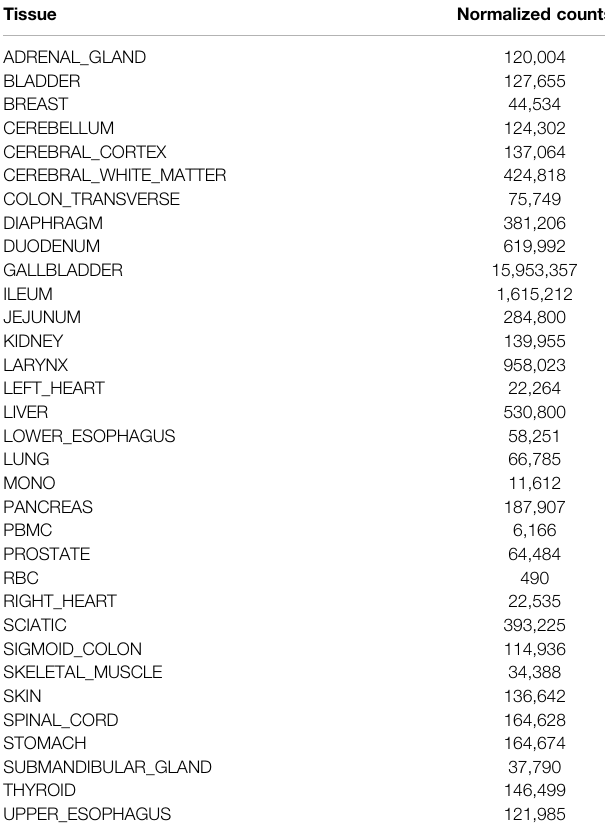
TABLE 2 | Tissue-enriched gallbladder tRF. A tRF sequence that is enriched in gallbladder is also highly expressed in many